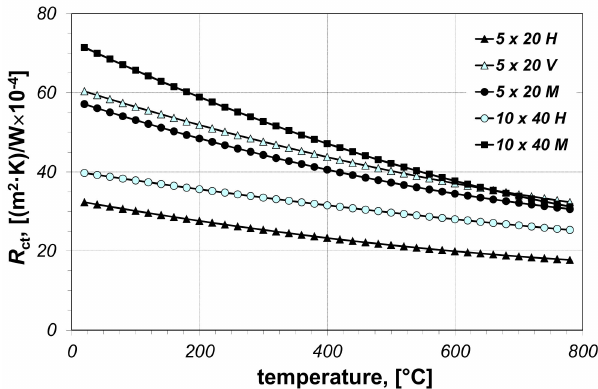
Figure 3. Measured values of the thermal contact resistance R ct of the beds of rectangular bars: H—horizontal sample, V—vertical sample, M—mixed